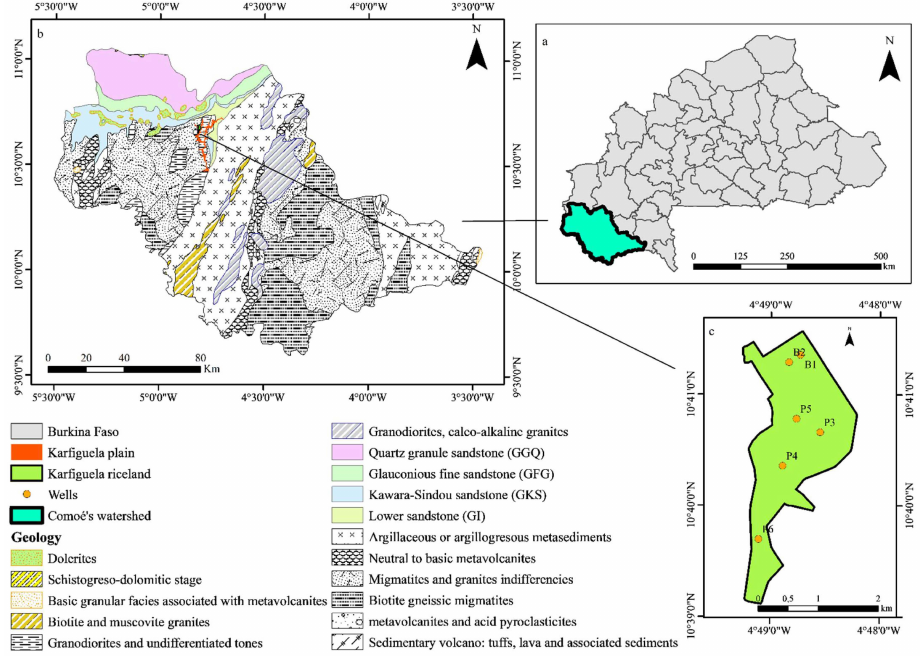
Figure 1. Location of the study area: ( a ) the Como é watershed in Burkina Faso, ( b ) geology of the upper Como é watershed, and ( c ) the monitoring network of the Karfigu é la paddy